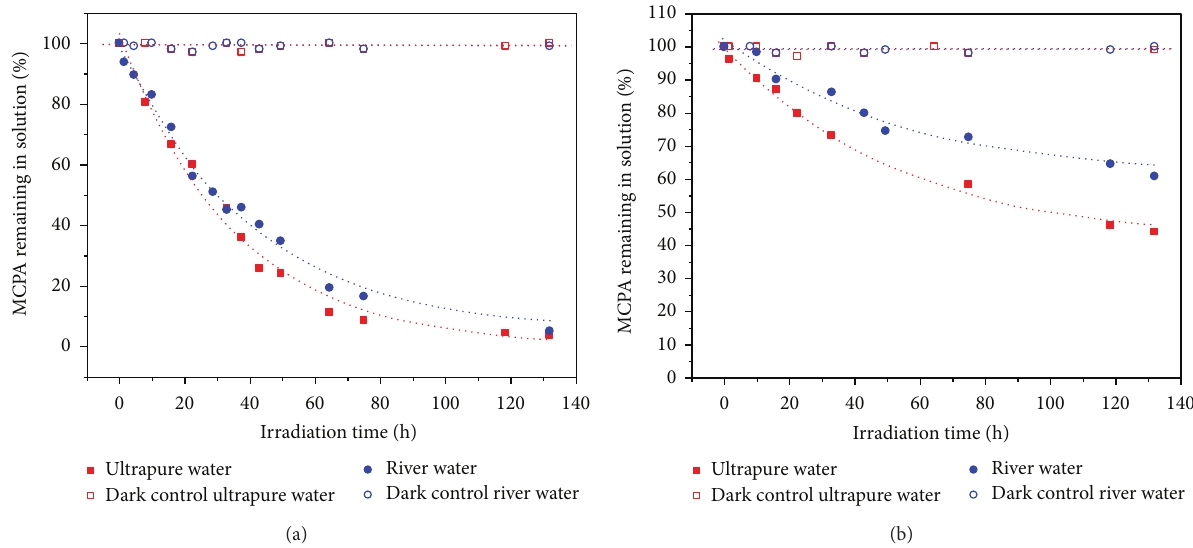
Figure 3: Photodegradation of (a) MCPA and (b) MCPA/HP- 𝛽 -CD inclusion complexes in (open red square, solid red square) ultrapure and (open blue circle, solid blue circle) river water under simulated solar